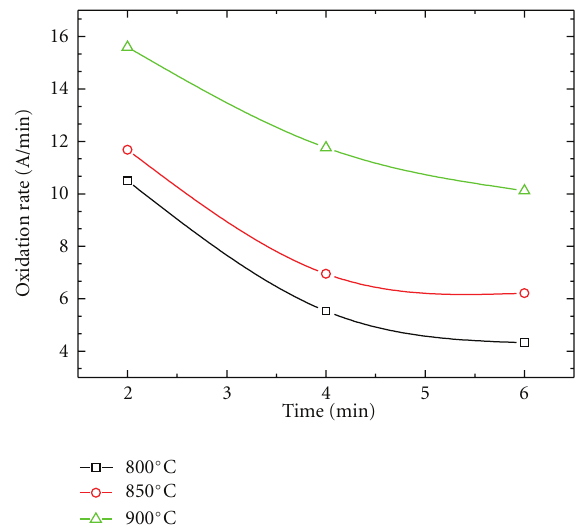
Figure 1: Oxidation rate of silicon substrate during rapid thermal annealing process at 800, 850, and 900 ◦ C with time.